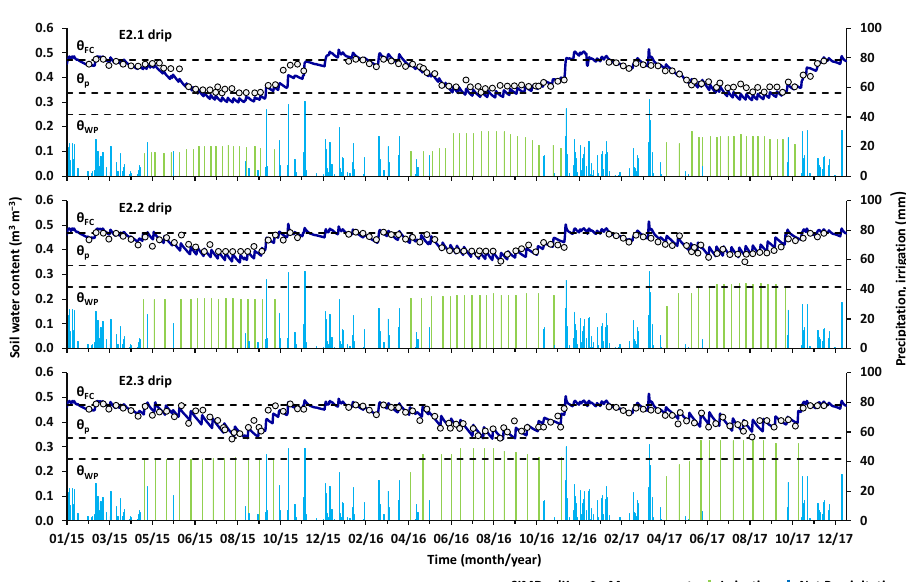
Figure 5. Measured and simulated soil water contents in the E2 treatments during the 2015–2017 growing seasons ( θ FC , θ WP , and θ p refer to soil water contents at field capacity, wilting point, and depletion fraction for no stress, respectively).